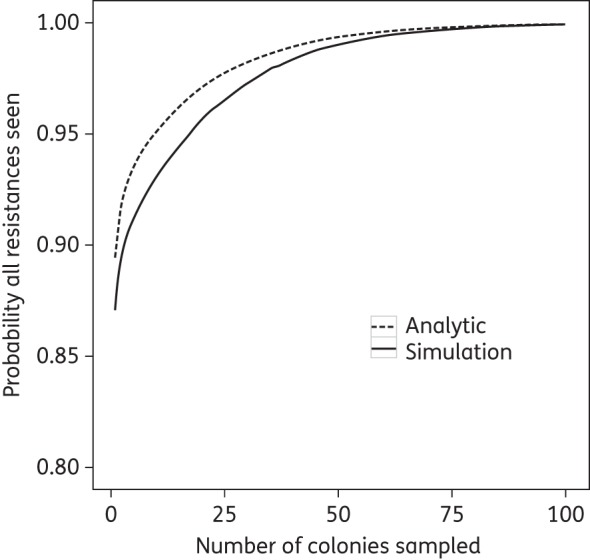
Probability of seeing all resistances in the patient by number of colonies sampled. The analytic solution has a higher probability as it assumes each patient only has up to two AMR profiles, whilst the simulation output (from 10 000 simulations) includes a patient with three profiles.